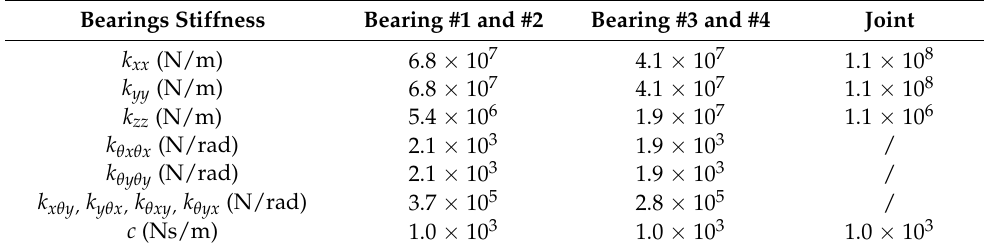
Table 2. Values of bearing stiffness and